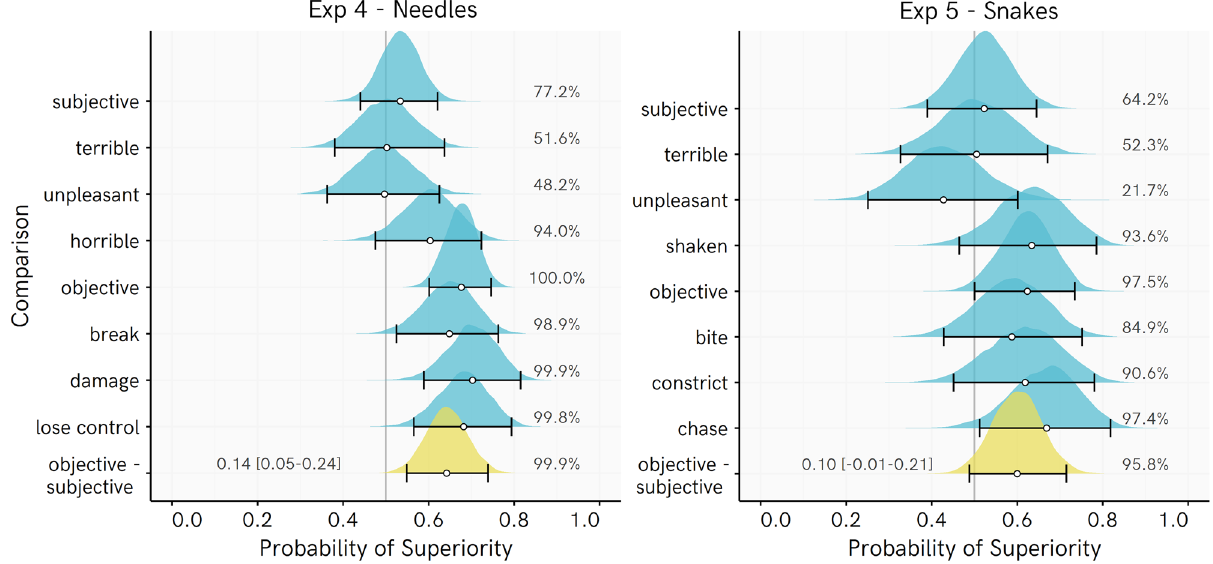
Figure 6. Posterior distribution of regression-based probability of superiority (PSup) estimates for Experiments 4 and 5. Each PSup value represents an estimate of the probability that a randomly picked Control score is higher than a randomly picked Bet score. Percentages indicate the proportion of the posterior PSup estimate > 0.5 (e.g., for objective events in Exp 4, 99% or more of every posterior is over 0.5, indicating very consistently higher ratings among Control than Bet participants). Points represent posterior median, whiskers represent 95% HDI, ridge height reflects density of estimate. Objective–Subjective = difference in PSup estimates for average of Objective beliefs vs. the average of Subjective beliefs, with values above 0 indicating a greater difference between Control and Bet participants in Objective than Subjective beliefs, with posterior median and [95% highest density interval]. Note that position of this density ridge on the X axis has been shifted by 0.5 so that the line at 0.5 represents 0 for this posterior